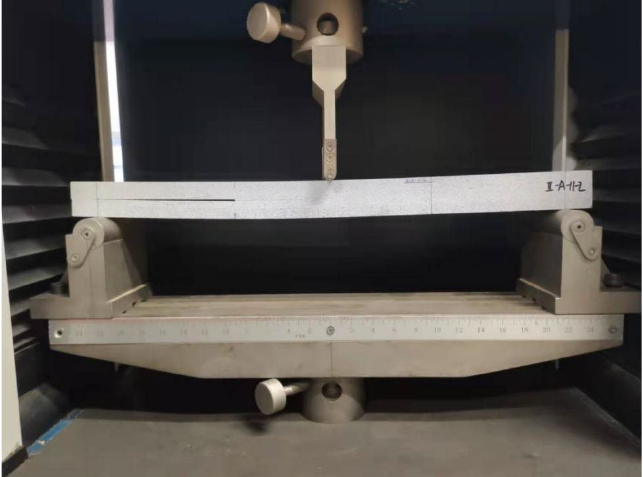
Figure 4. Experimental procedure .